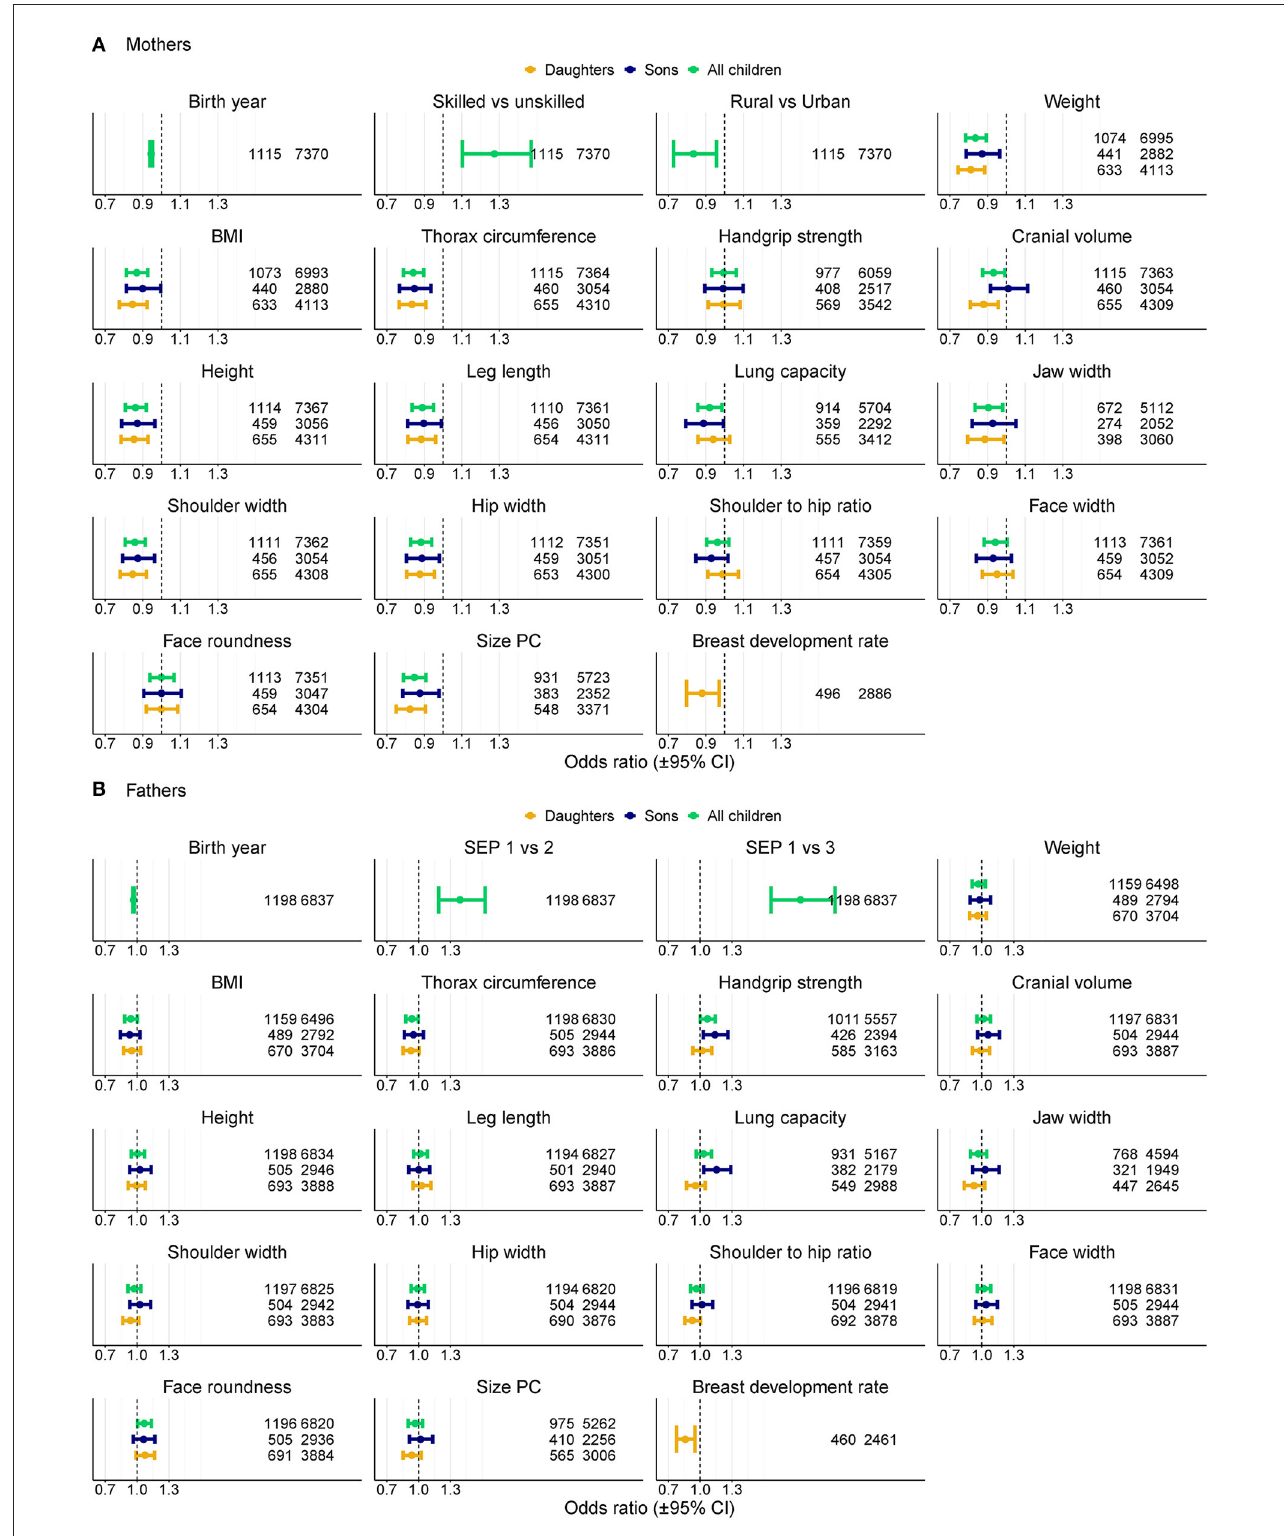
FIGURE2 Association between anthropometric traits of children and longevity (i.e., odds of belonging to the top 90th percentile vs. below 60th percentile of lifespan) of their parents in logistic regression models. ORs for anthropometric traits are per one standard deviation of trait z-score values. OR for year of birth is per year, Rural is for rural vs. urban origin. SEP for mothers is skilled professions vs. manual unskilled workers, SEP for fathers is 1 for unskilled manual, 2 for skilled manual and 3 for non-manual professions. Models for all anthropometric traits control for parents’ year of birth, SEP and rural origin (for mothers only). Numbers denote sample sizes for longevous vs. non-longevous parents. (A) Mothers, (B)